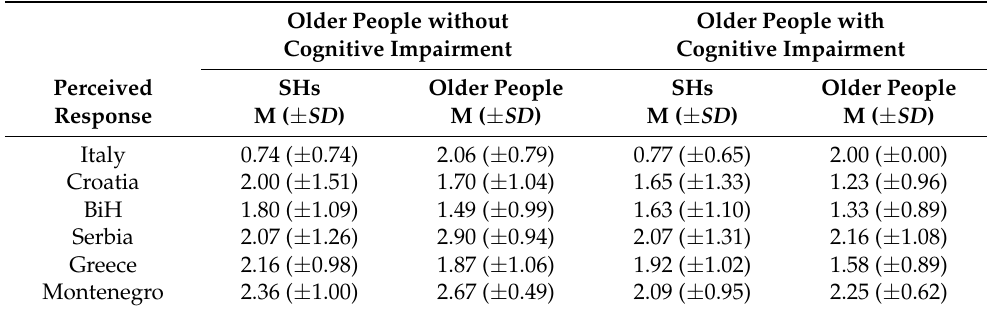
Table 2. Descriptive statistics of perceived response of the healthcare system during the COVID 19 pandemic by older people group (with vs. without cognitive impairment) and country of residence. Older People without Cognitive Impairment